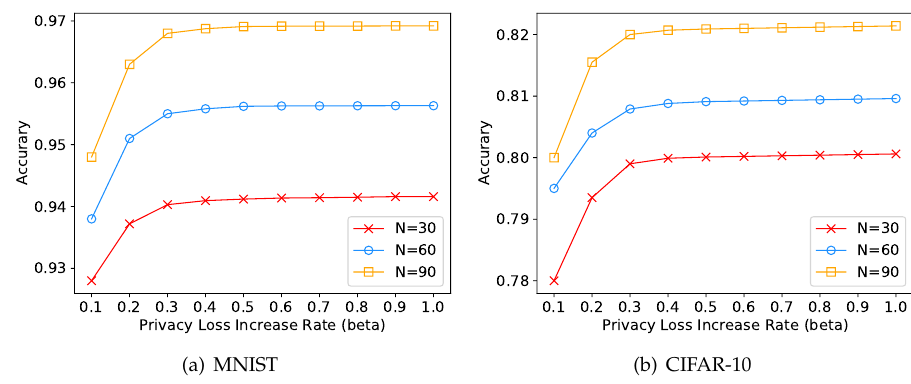
Figure 9. The model accuracy under different privacy loss increase rates for 30, 60, and 90 participants under